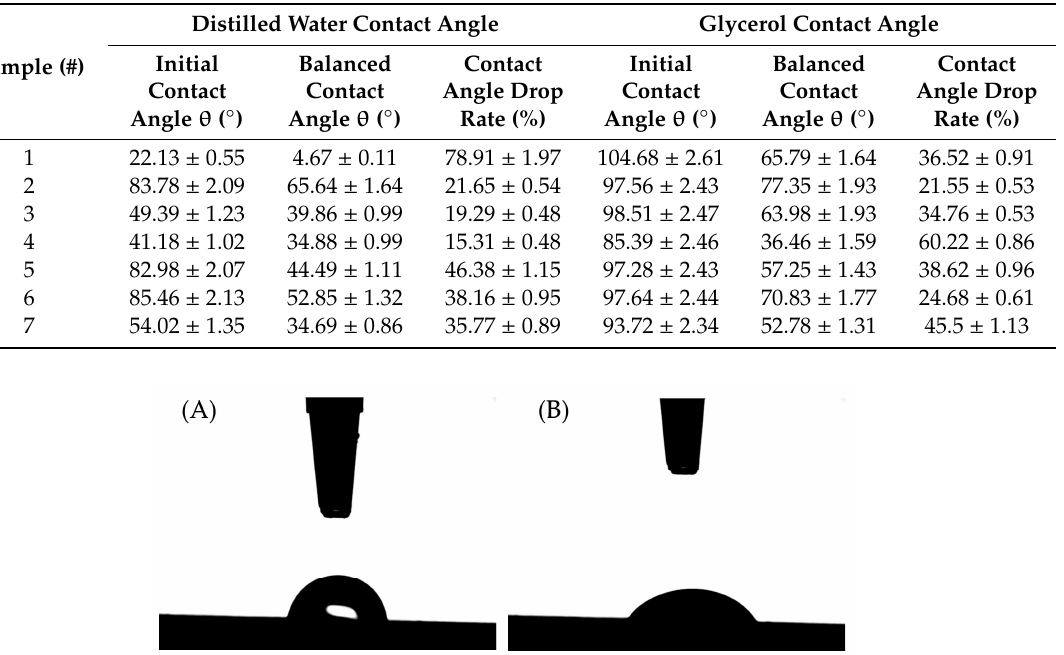
Figure 2. Photograph of the initial ( A ) and equilibrium ( B ) contact angle of distilled water (Sample 4#).